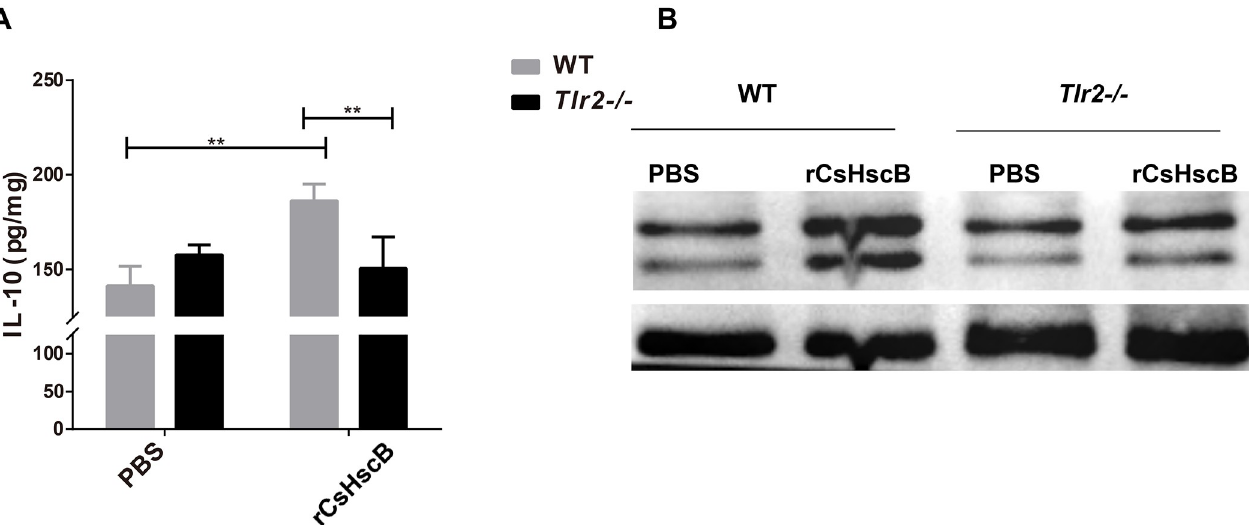
Fig 6. rCsHscB increased IL-10 production in the liver of mice via TLR2/ERK1/2 signaling pathway. The mice of TLR2 wild type and TLR2 KO mice were administrated with rCsHscB or PBS for 24 h i . v ., and the mice were sacrificed and the livers from each mouse were collected for IL-10 and p-ERK1/2 detection. (A) IL-10 production in supernatant of hepatic homogenate from each group was determined by ELISA. (B) Phosphorylation of ERK1/2 was attenuated in TLR2 KO mice that were received rCsHscB determined by western-blot. Quantitative data are representative of mean ± SEM of at least three independent experiments (n = 5). �� P < 0.01, compared with the indicated